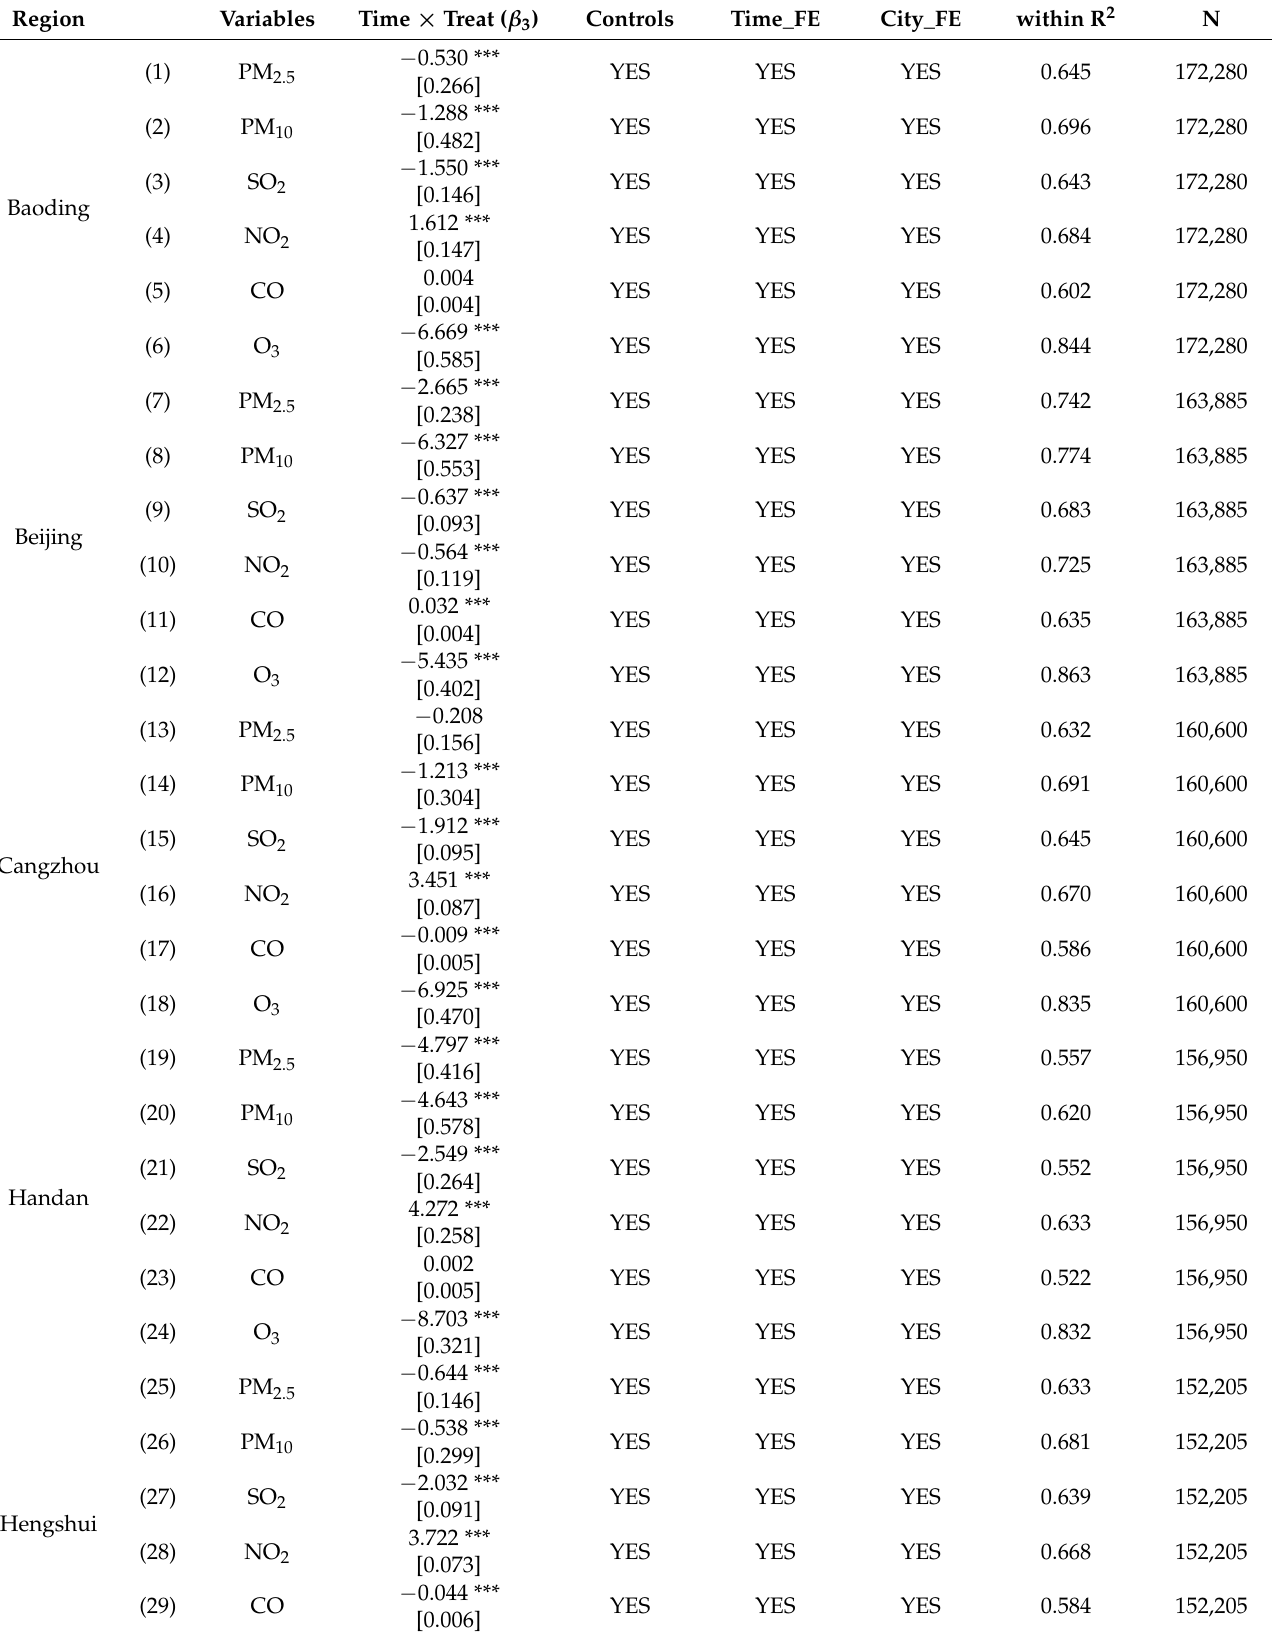
Table 6. Estimation results of the BSDW policy on different